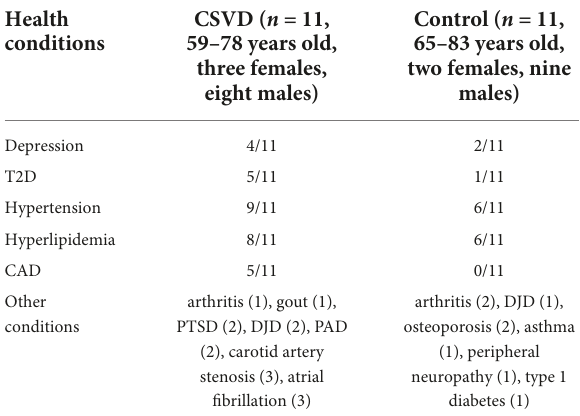
TABLE 1 Characteristics of the study population.